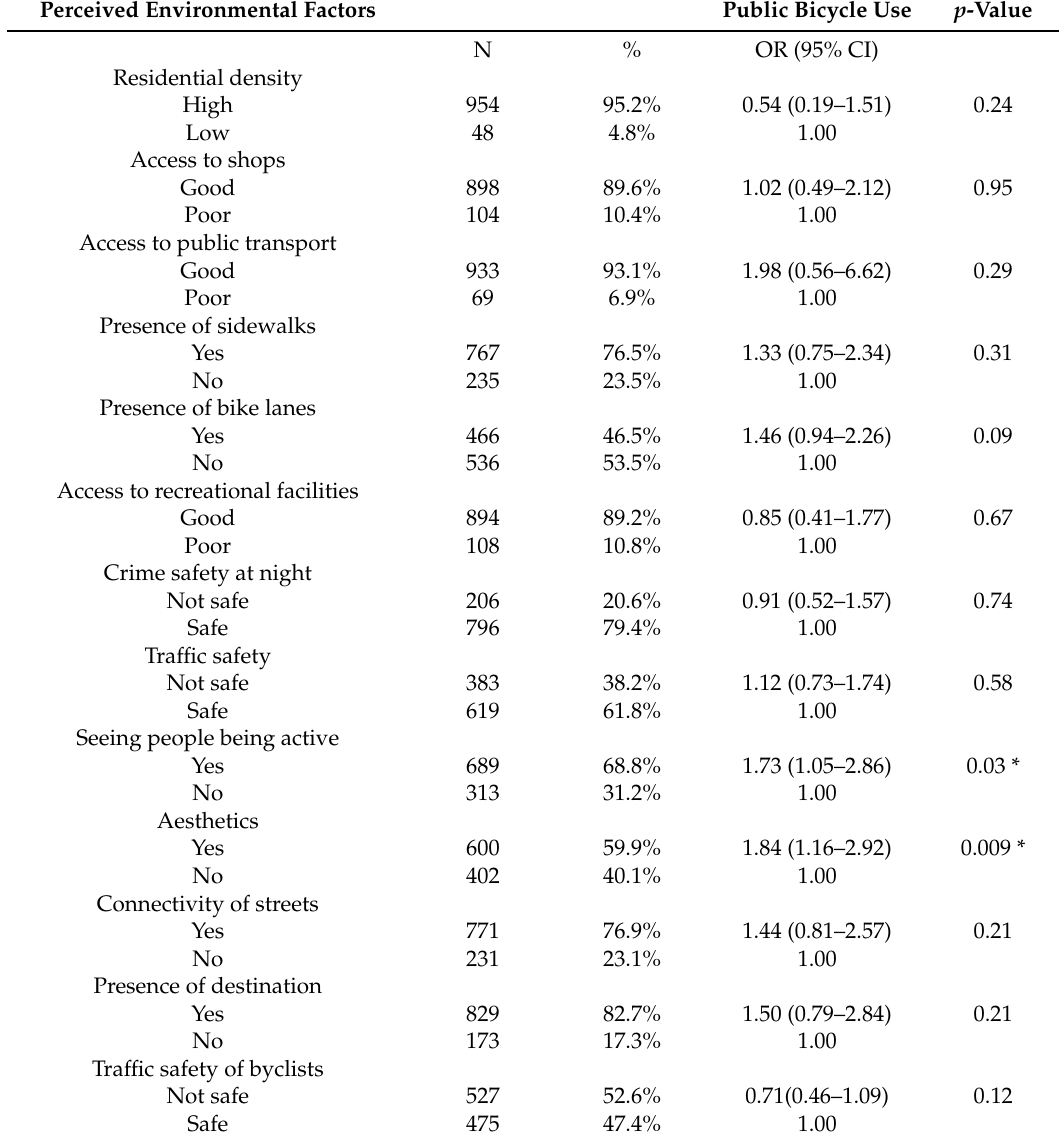
Table 3. Perceived environmental factors associated with public bicycle use among Taiwanese